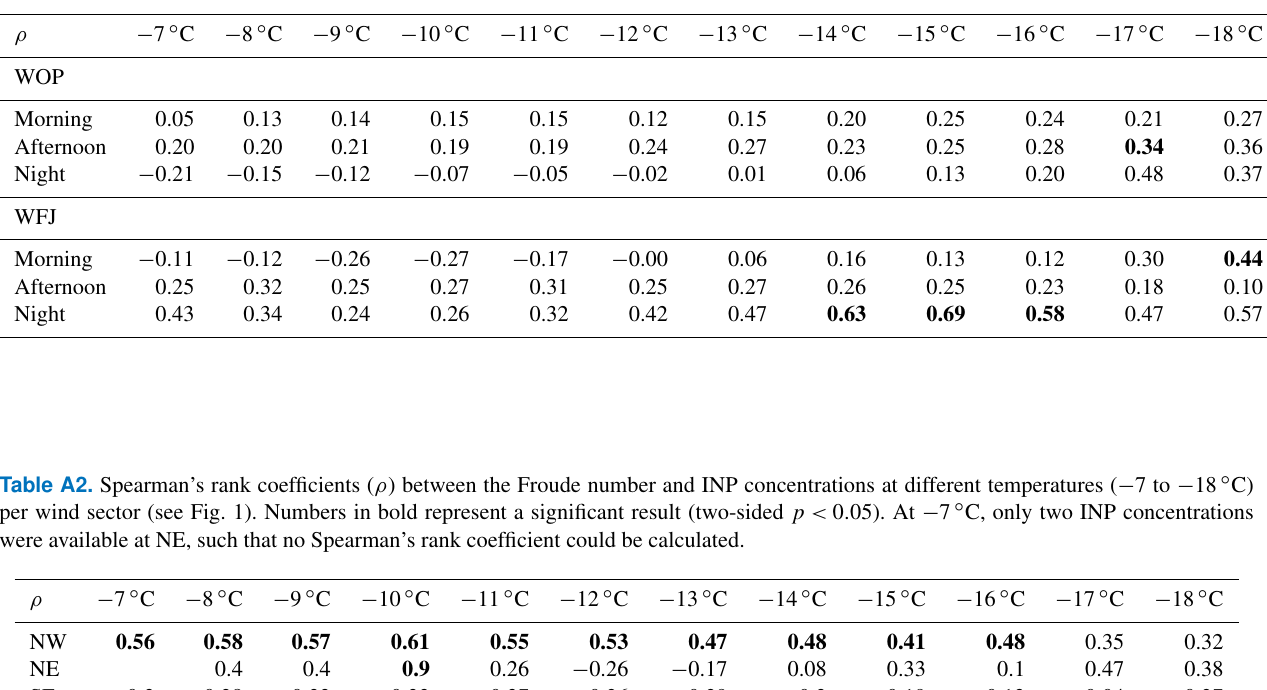
Table A1. Spearman’s rank coefficients ( ρ ) between aerosol number concentration for particles with physical diameter larger than 0.5µm ( n 0 . 5µm ) and INP concentration at different temperatures ( − 7 to − 18 ◦ C) at WOP and WFJ for the three periods in the morning (03:00–